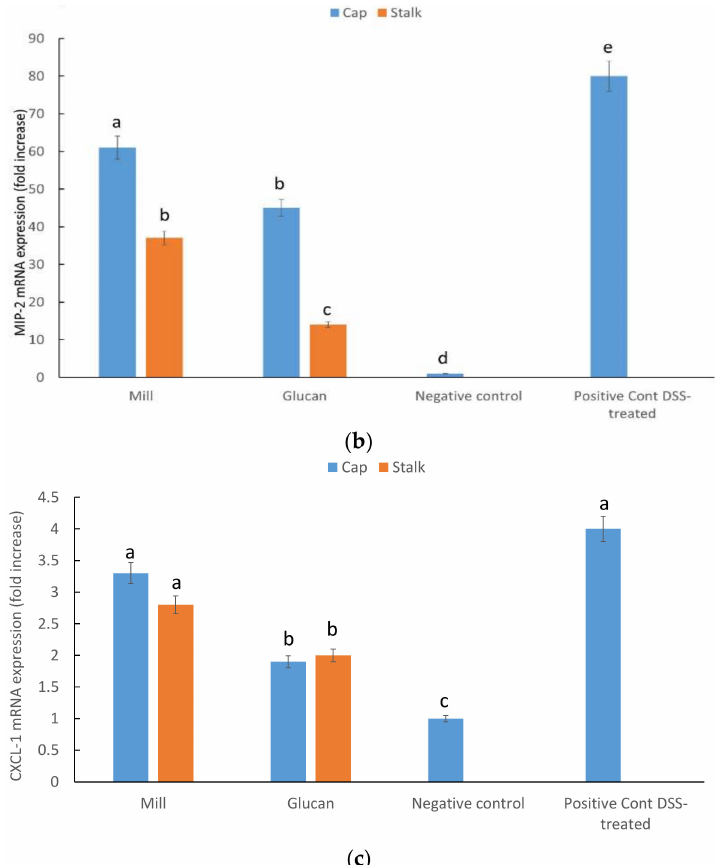
Figure 4. Effect of mill and isolated glucans from caps and stalks of P. eryngii mushrooms (1 mg glucan/kg mice BW) on ( a ) INF- γ mRNA levels ( b ) Mip-2 levels mRNA levels and ( c ) CXCL1 mRNA levels in colonic samples relative to negative control (no treatment). DSS was administrated for 7 days and mill and glucan extract treatment started with DSS treatment and continued until day 16 when all mice were sacrificed and tissue samples were taken for analysis. Data represent mean ± SD of six mice per group. Different letters indicate significantly different values at p <